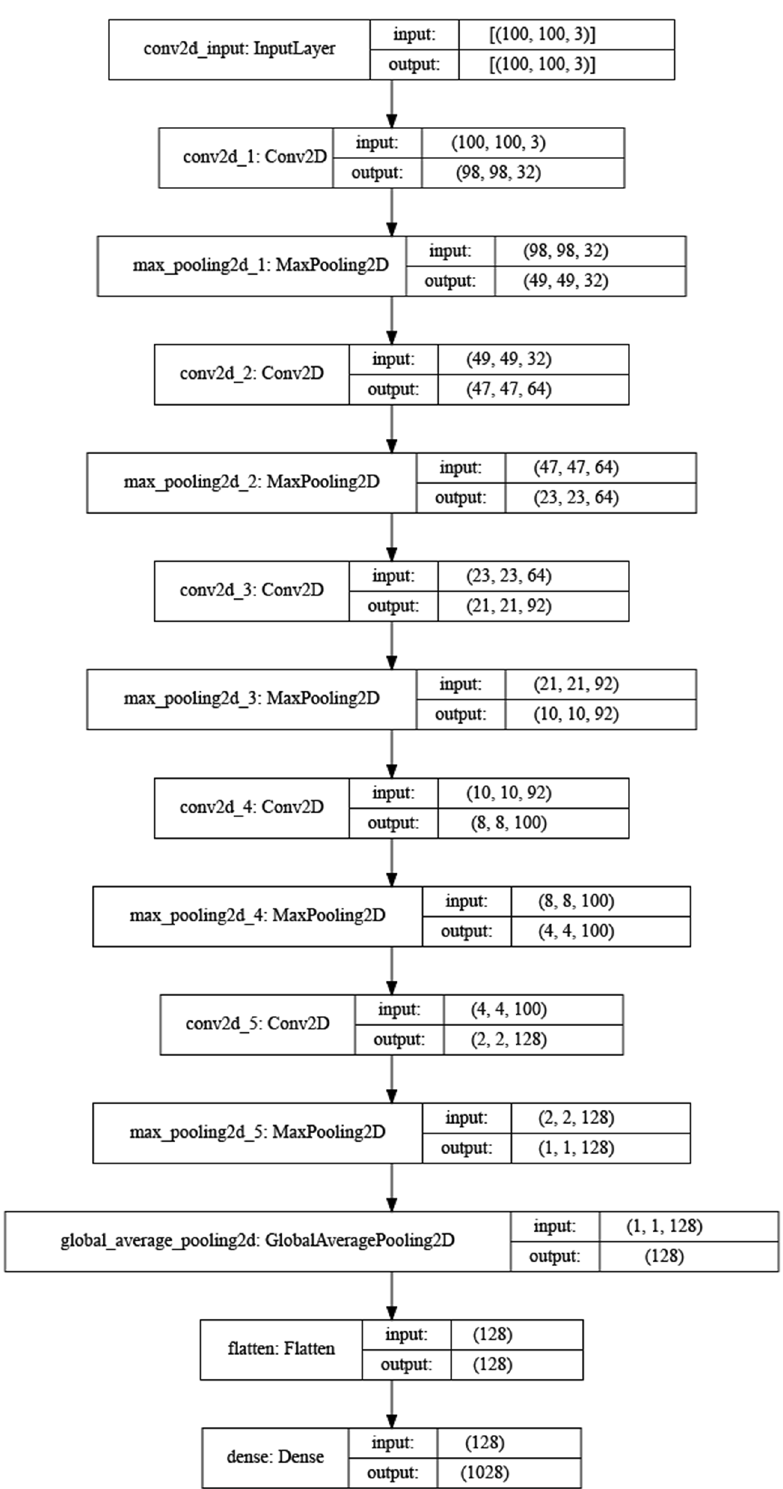
Figure 4. The T2D5 deep learning architecture. The model contained five convolutional layers (the numbers of each layer: 32, 64, 92, 100 and 128). Additionally, a Maxpooling layer was included after each convolution layer. Next, the outputs from convolutional layers were subjected to global average pooling and flattened for a fully connected layer (1028 nodes). Finally, a Softmax classifier, which applies a categorical cross-entropy loss function, was